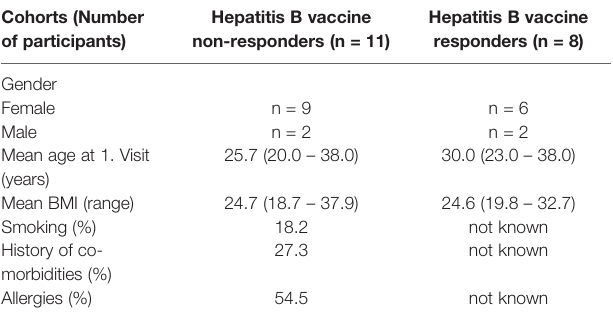
TABLE 1 | Characteristics of study cohorts. Cohorts (Number Hepatitis B vaccine of participants) non-responders (n =